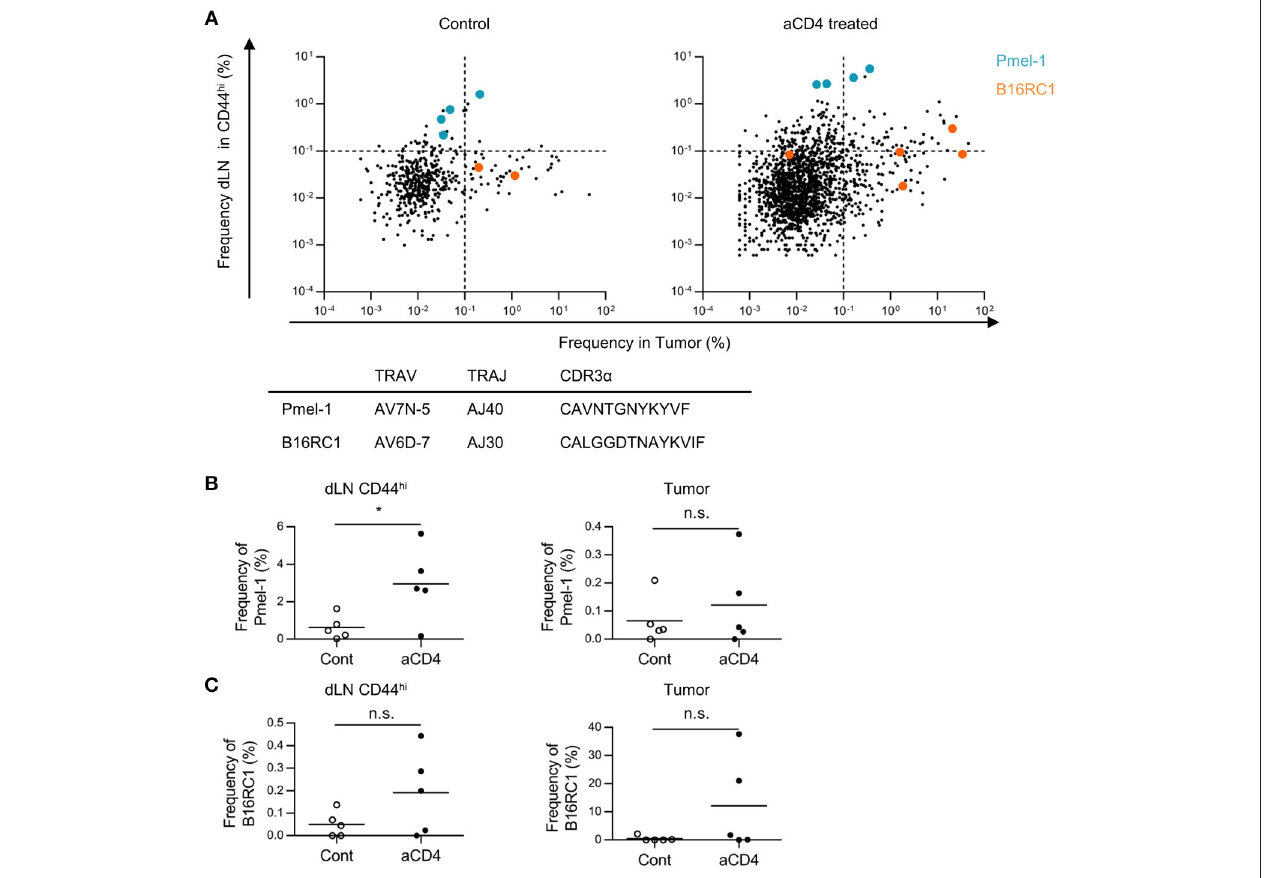
FIGURE 6 | Patterns in dLN-tumor overlap differed in tumor reactive clones. Mice bearing B16F10 tumors were injected i.p. with anti-CD4 mAb on days 5 and 9, and analyzed on day 14 after tumor inoculation. (A) Scatter Plot of overlapping clones between the tumor and dLN in TCR α repertoire. Each point on the plot represents a single clone with log 10 frequency in the tumor (x-axis) and the dLN CD44 hi (y-axis). Pmel-1 and B16RC1 are plotted in blue and orange, respectively. (B,C) Frequency of Pmel-1 (B) and B16RC1 (C) in dLN CD44 hi (left) and tumor (right). All figures present the data for TCR α . In (B,C) , T cell clones were determined as the TCR reads with the same TCR V segment, J segment, and CDR3 amino acid sequence. Two-sided unpaired Student’s t -tests ( n = 5, except for PBL of aCD4: n = 3). * P <